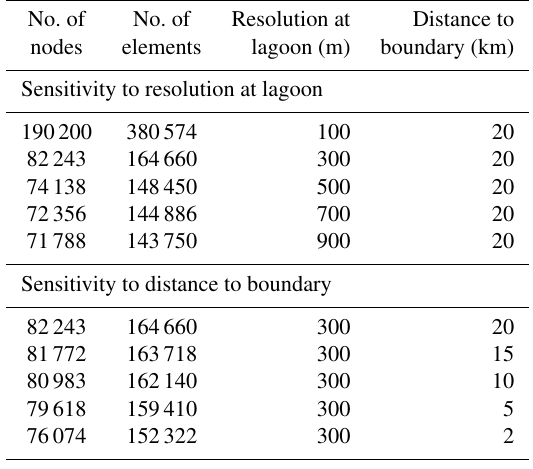
Table 2. Summary of the different meshes used for the study. The mesh resolution at the coastlines was set at 50m and permitted to gradually increase in size up to 15km towards the open boundaries.